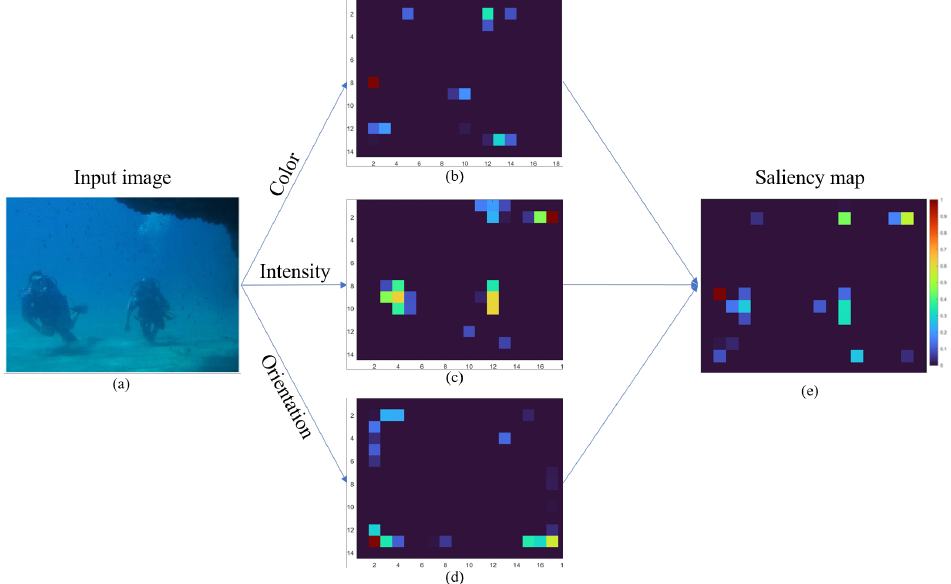
Figure 3. Example of application of Itti’s model: ( a ) original image, ( b ) color conspicuity maps, ( c ) intensity conspicuity maps, ( d ) orientations conspicuity maps, ( e ) saliency map. All units are arbitrary